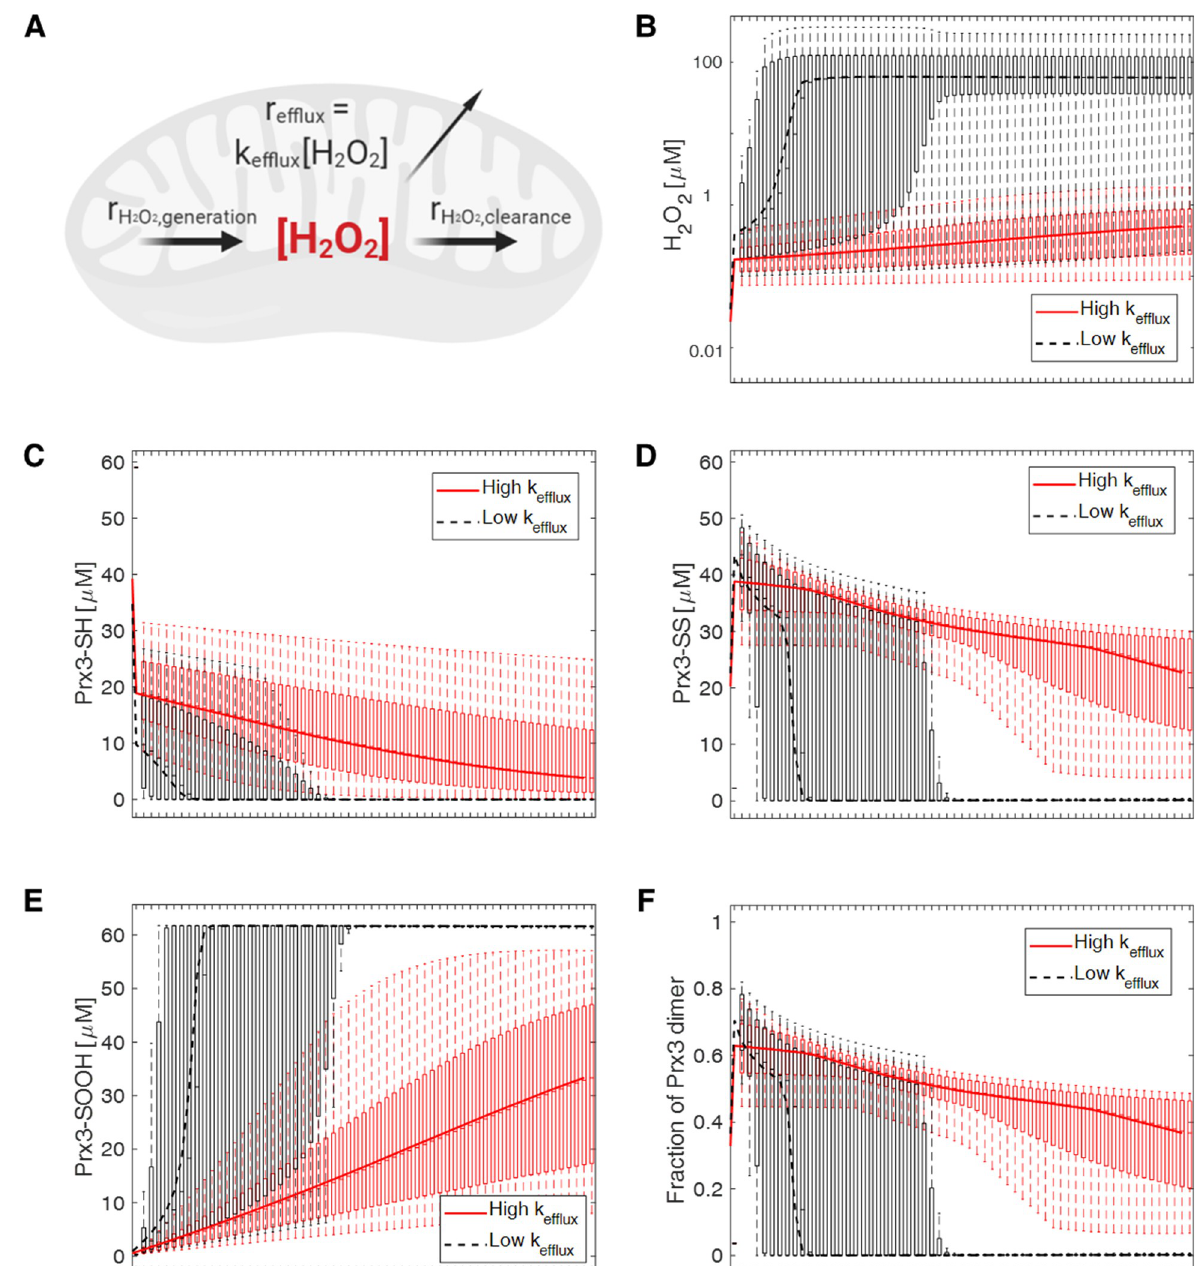
Fig 6. Model refinement and predictions with H 2 O 2 efflux rate. A) Schematic of a refined kinetic model that includes the rate of H 2 O 2 efflux. B) Model predictions of H 2 O 2 dynamics under high production rates of H 2 O 2 with either low or high efflux rate. 10,000 samples were randomly generated based on uniform distribution of rates ranging from 50 to 100 μ M/s for k DAAO , 0 to 50 μ M/s for low k efflux conditions, and 50 to 100 μ M/s for high k conditions. Lines represent median values. Points represented in box plot form show 2.5, 25, 75, and 97.5 percentile values at times efflux ranging from 0 to 60 minutes. Dynamic behaviors of Prx3-SH, Prx3-SS, Prx3-SOOH, and the fraction of Prx3 dimer are presented in C), D), E) and